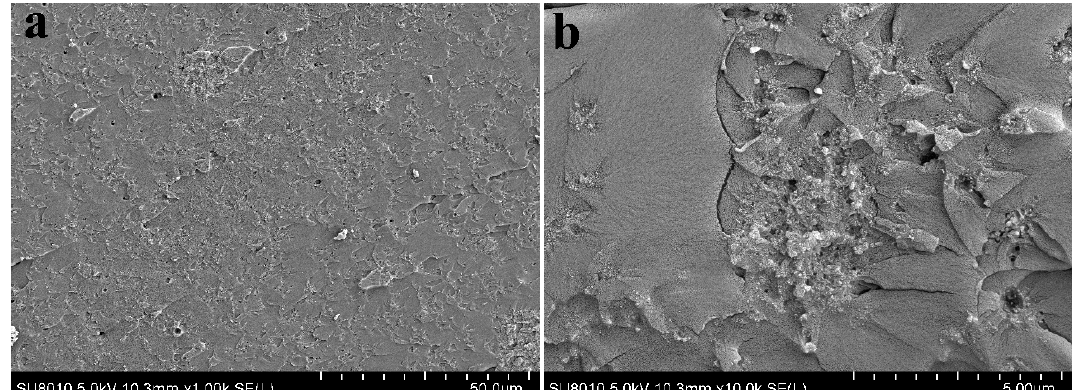
Figure 8. Cont. Figure 8. Cont.